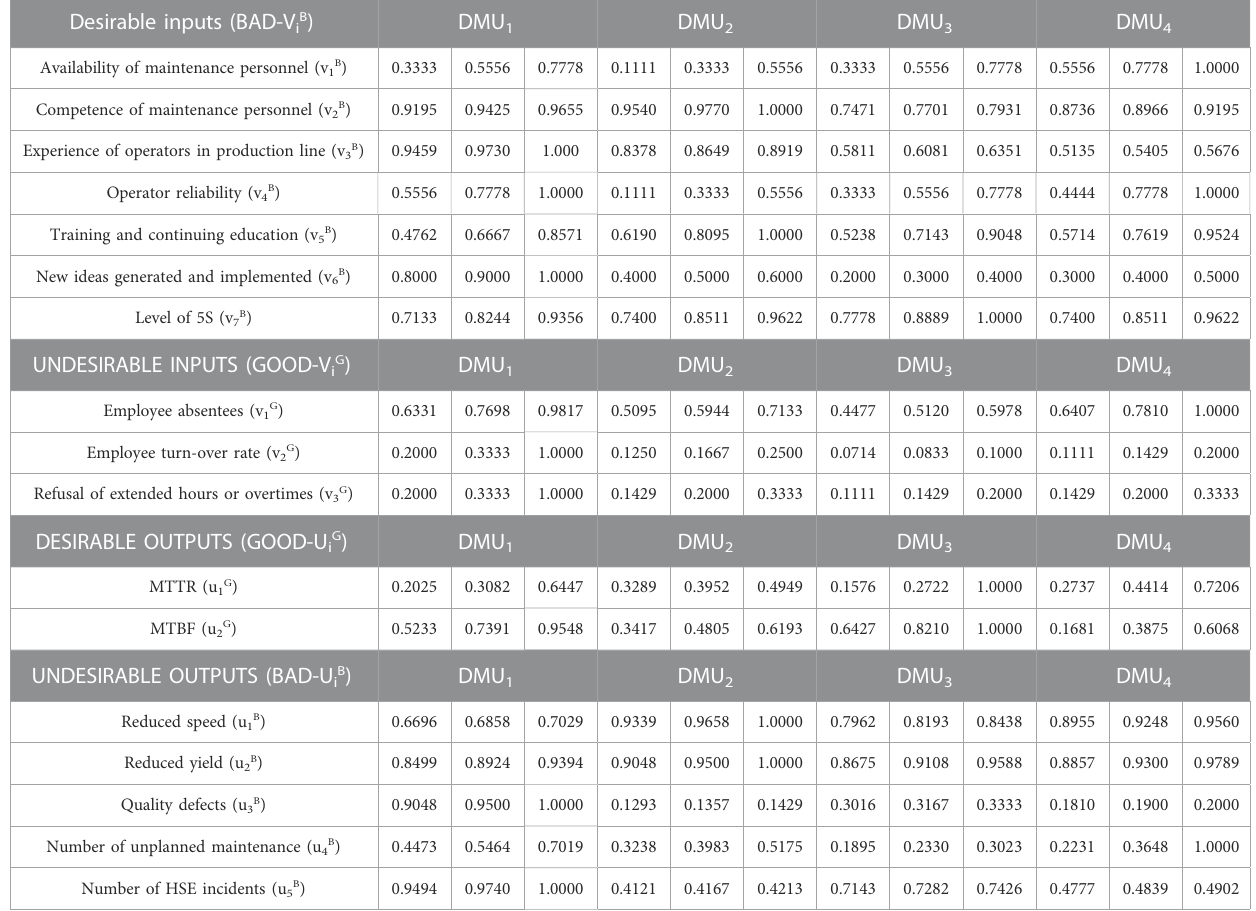
TABLE 8 Fuzzy normalized values of the relevant data for inputs and